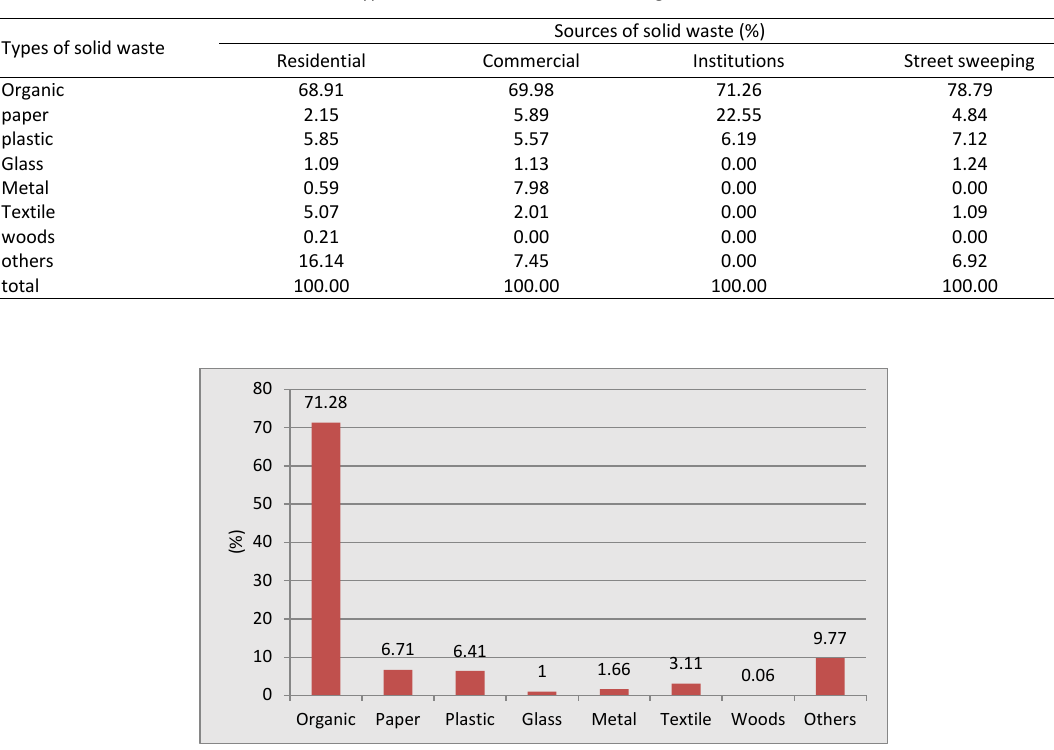
Fig. 2: Overallsolid waste composition in Yirgalem town